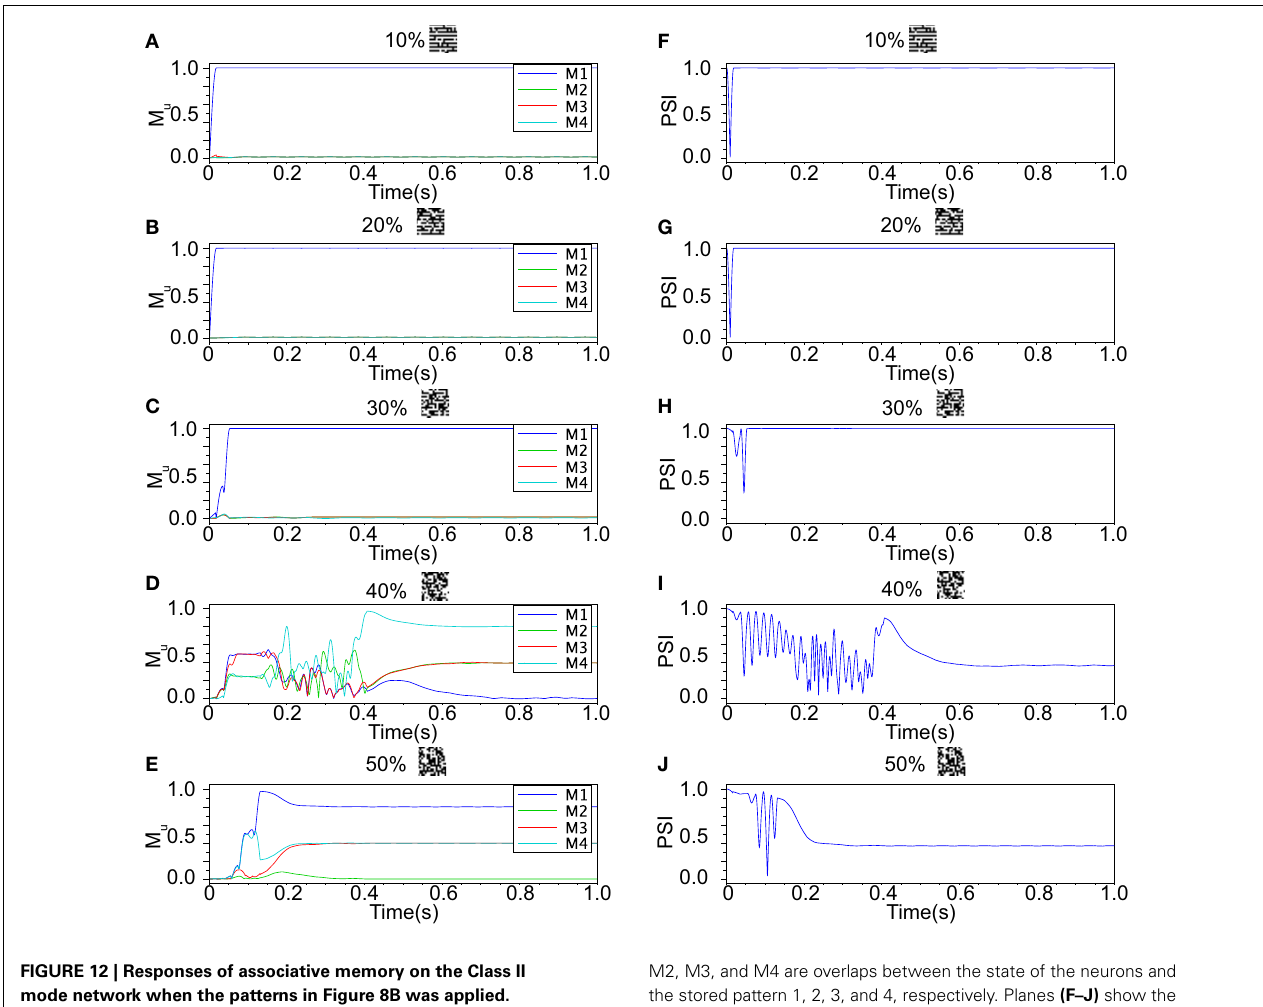
FIGURE 12 | Responses of associative memory on the Class II mode network when the patterns in Figure 8B was applied. Planes (A–E) show the overlaps when the input pattern contains from 10 to 50% errors. In each plane, four colored curves labeled as M1,